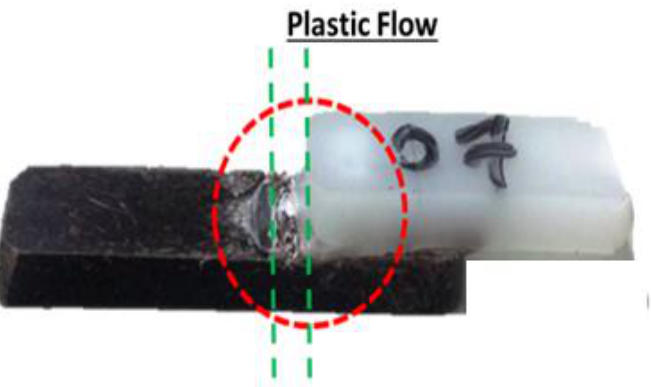
Figure 5. Flow between polymeric joints. Table 3. Combined ANOVA for the 12- and 16-mm